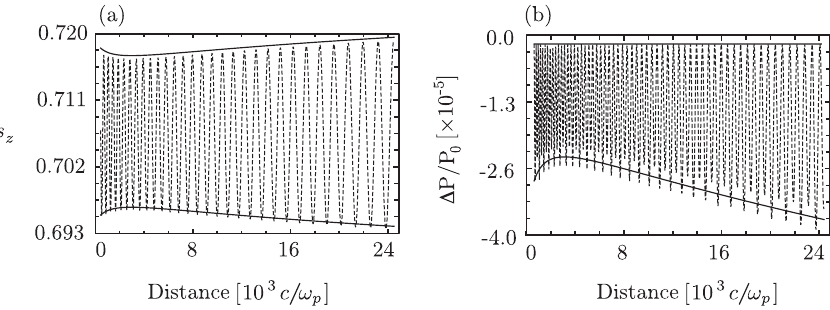
FIG. 4. Comparison between the analytical model and the numerical resolution of the T-BMT equations using prescribed fields. ¼ 0 : 1 , which accelerates in a constant accelerating gradient (a) Longitudinal component of the spin evolution for a beam with (cid:7) r ¼ 0 : 6 , with (cid:6) ¼ 0 : 35 . (b) Evolution of the total depolarization of the beam. The solid line corresponds to the analytical result, E accel while the dashed line corresponds to the numerical ¼ 2 : 4 (cid:1) 10 15 cm (cid:2) 3 , E ¼ 0 : 7 , and (cid:6) ¼ 0 : 35 . The n 0 accel